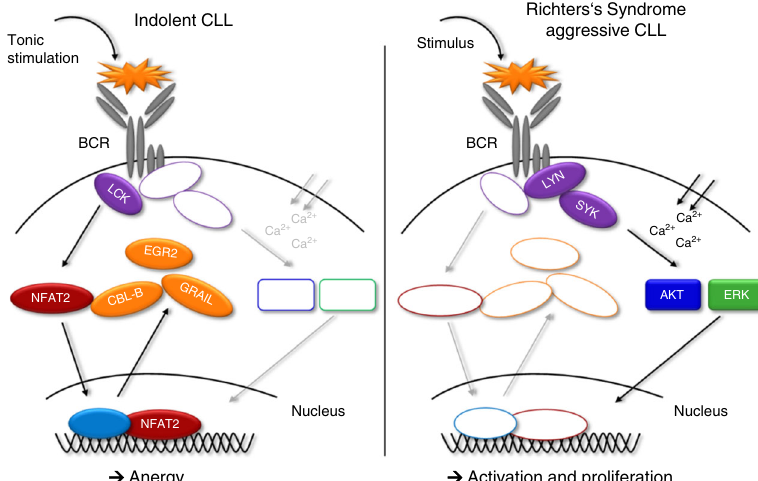
Fig. 8 Putative mechanism of the role of NFAT2 in the regulation of the anergic phenotype in CLL. ( Left panel ) Tonic stimulation of the BCR in indolent CLL is associated with the recruitment of LCK and the activation of NFAT2, which subsequently translocates to the nucleus to induce the transcription of several anergy-associated genes including Cbl-b , Grail , Egr2 as well as Lck . ( Right panel ) In the absence of NFAT2, BCR stimulation leads to enhanced phosphotyrosine induction and calcium fl ux culminating in the activation of AKT and ERK and subsequent cell proliferation as observed in patients